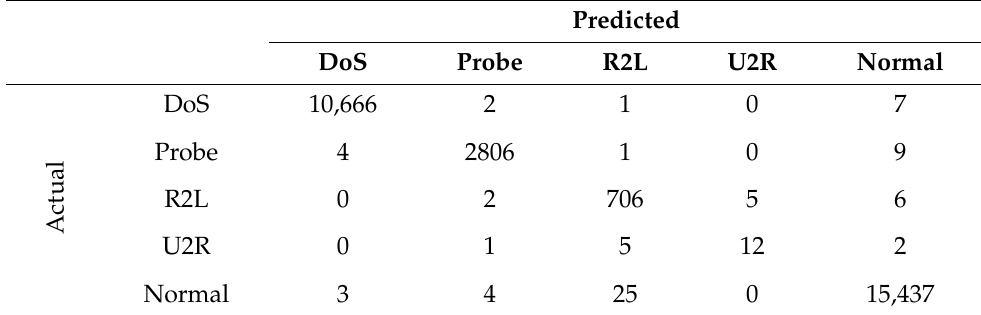
Table 11. Confusion matrix for NSL-KDD “modified distribution” multiclass classification